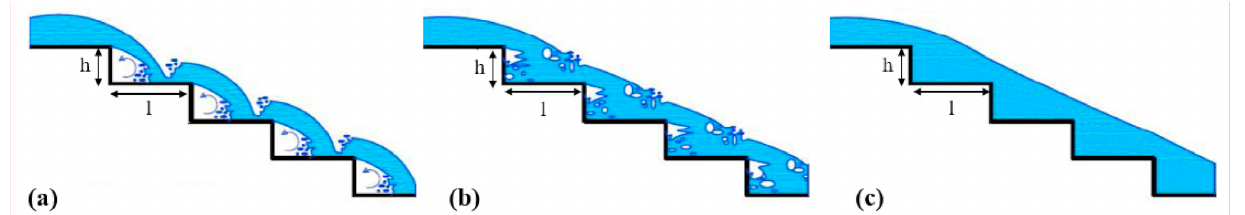
Figure 1. Flow regimes on stepped spillways: ( a ) Nappe flow, ( b ) Transition flow, ( c ) Skimming flow.